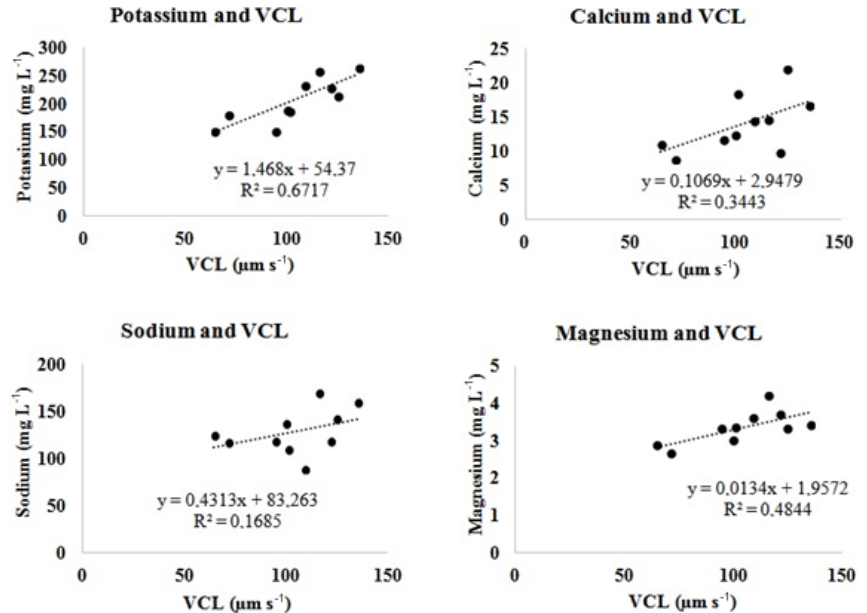
Figure 1. Linear regression graphics between some ions of semen seminal plasma and the VCL value of sperm cell in Capoeta trutta .